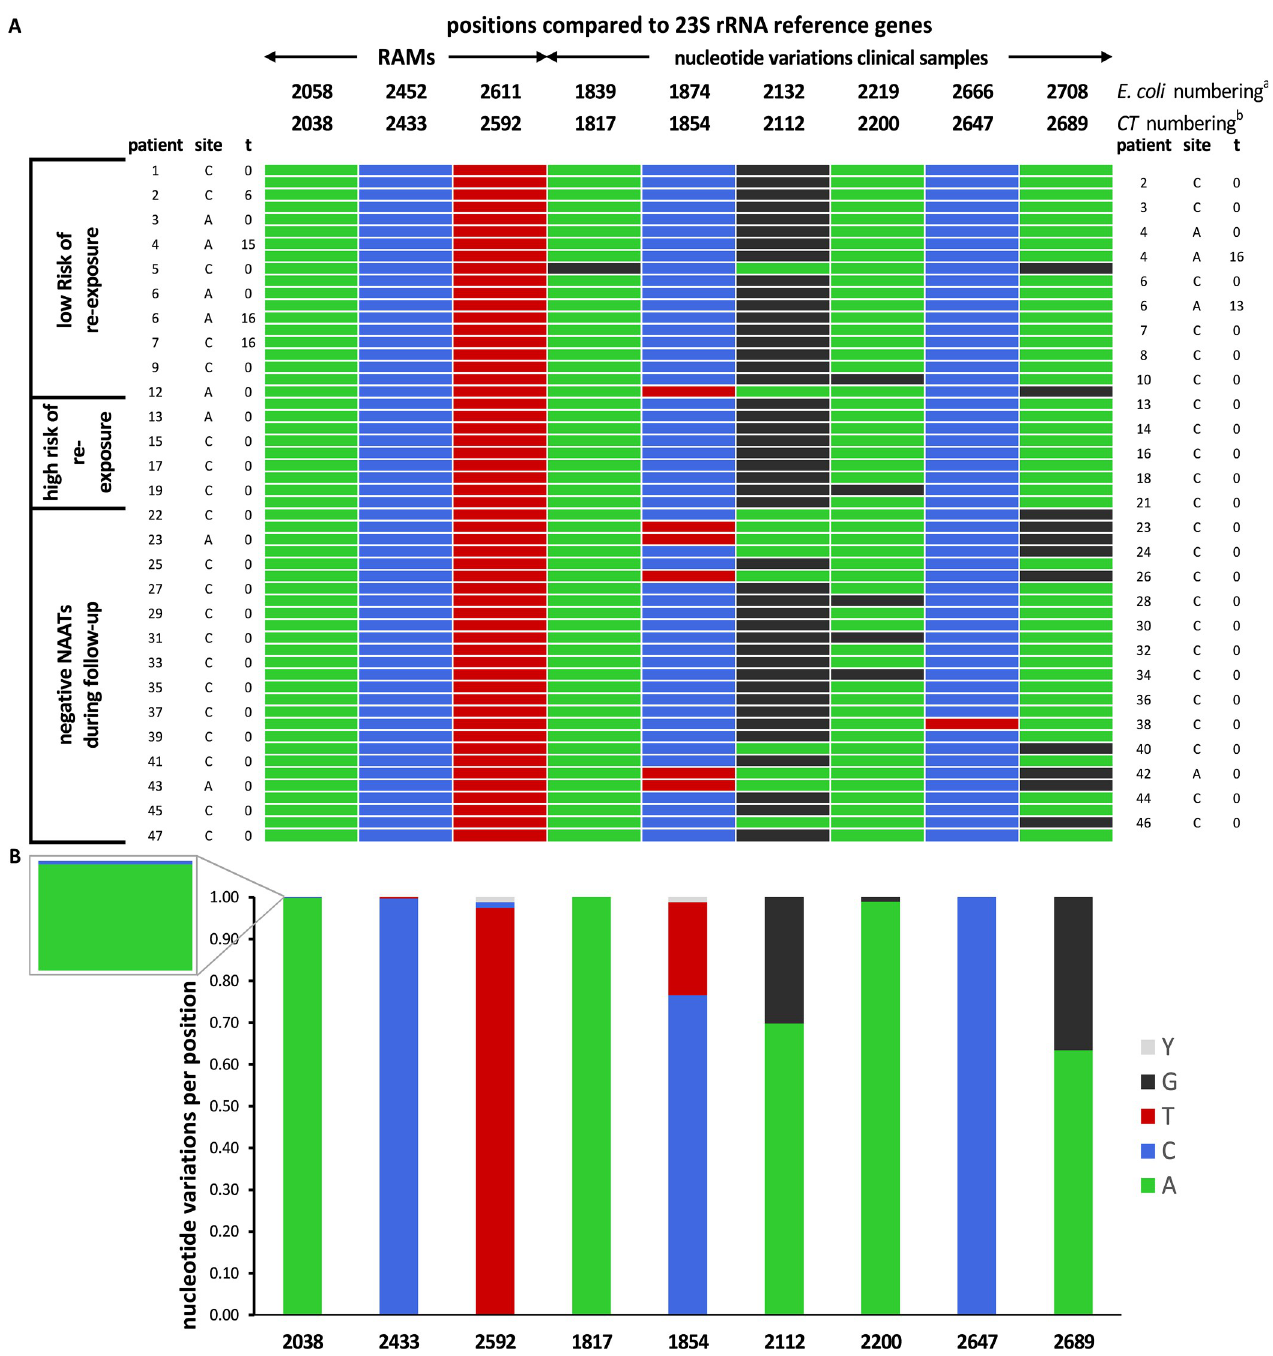
Fig 3. Resistance associated mutations in the Chlamydia trachomatis 23S rRNA gene. Resistance associated mutations (RAMs) in the CT 23S rRNA gene and nucleotide variants in a clinical sample of azithromycin treated cases, and frequency of these mutations in NCBI GenBank. A. Known macrolide RAMs and nucleotide variations found in the clinical samples, both displayed in E . coli numbering ( a NC_017625, 456981–459884) and relative to CT 23S rRNA gene ( b NC_000117.1, 878039–880902). A1817G and C2647T are novel mutations. Sequences are available through accession numbers OM320821 to OM320875 (S3 Table). Site of infection: C is a cervicovaginal infection. A is an anorectal infection. B. Occurrence of these mutations (both RAMs and nucleotide variants) in NCBI GenBank. Nucleotide frequencies (A/C/G/T/Y) are relative to 23S rRNA gene NC_000117.1 (878039–880902). Sequences were obtained from the